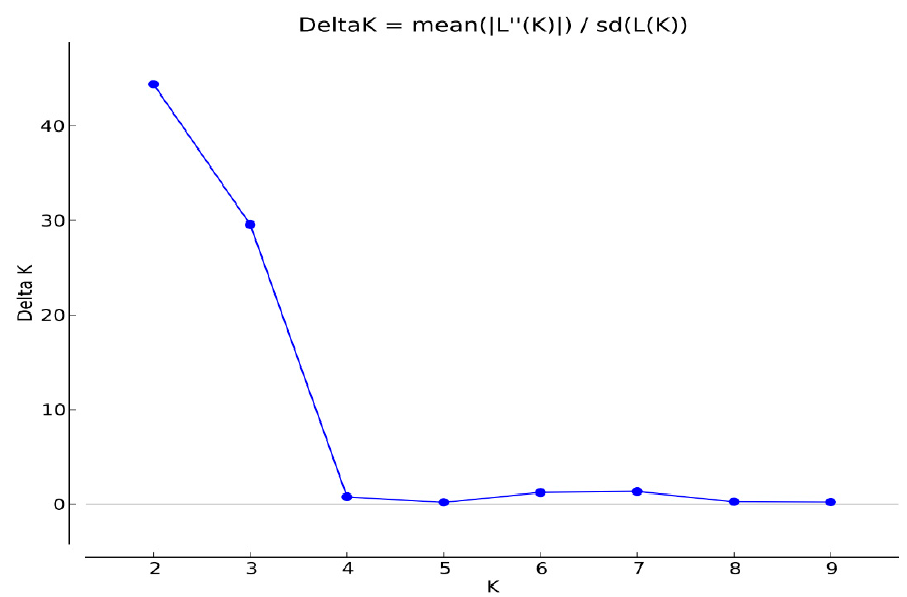
Figure 2. The magnitude of ∆ K as a function of K; the peak value of ∆ K was at K = 2, suggesting two genetic groups in the 37 maize landrace accessions.